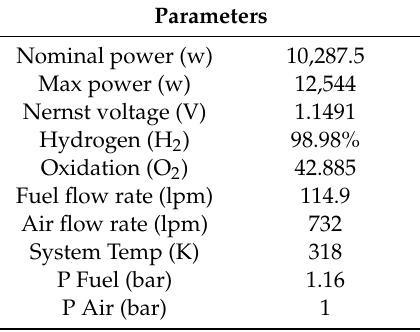
Figure 7. I – V curve for the FC used in proposed system. Table 2. Data sheet parameters of the proton exchange membrane fuel cell (PEMFC).